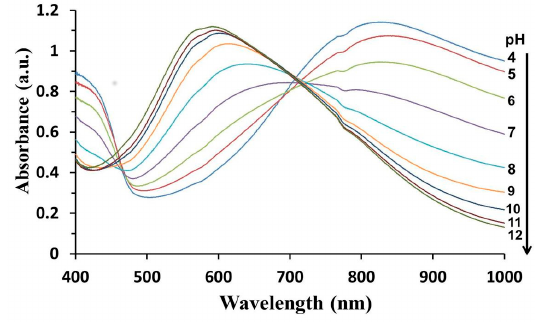
Figure 4. Absorption spectra of the PANI-PSU-20 membranes at different pH.